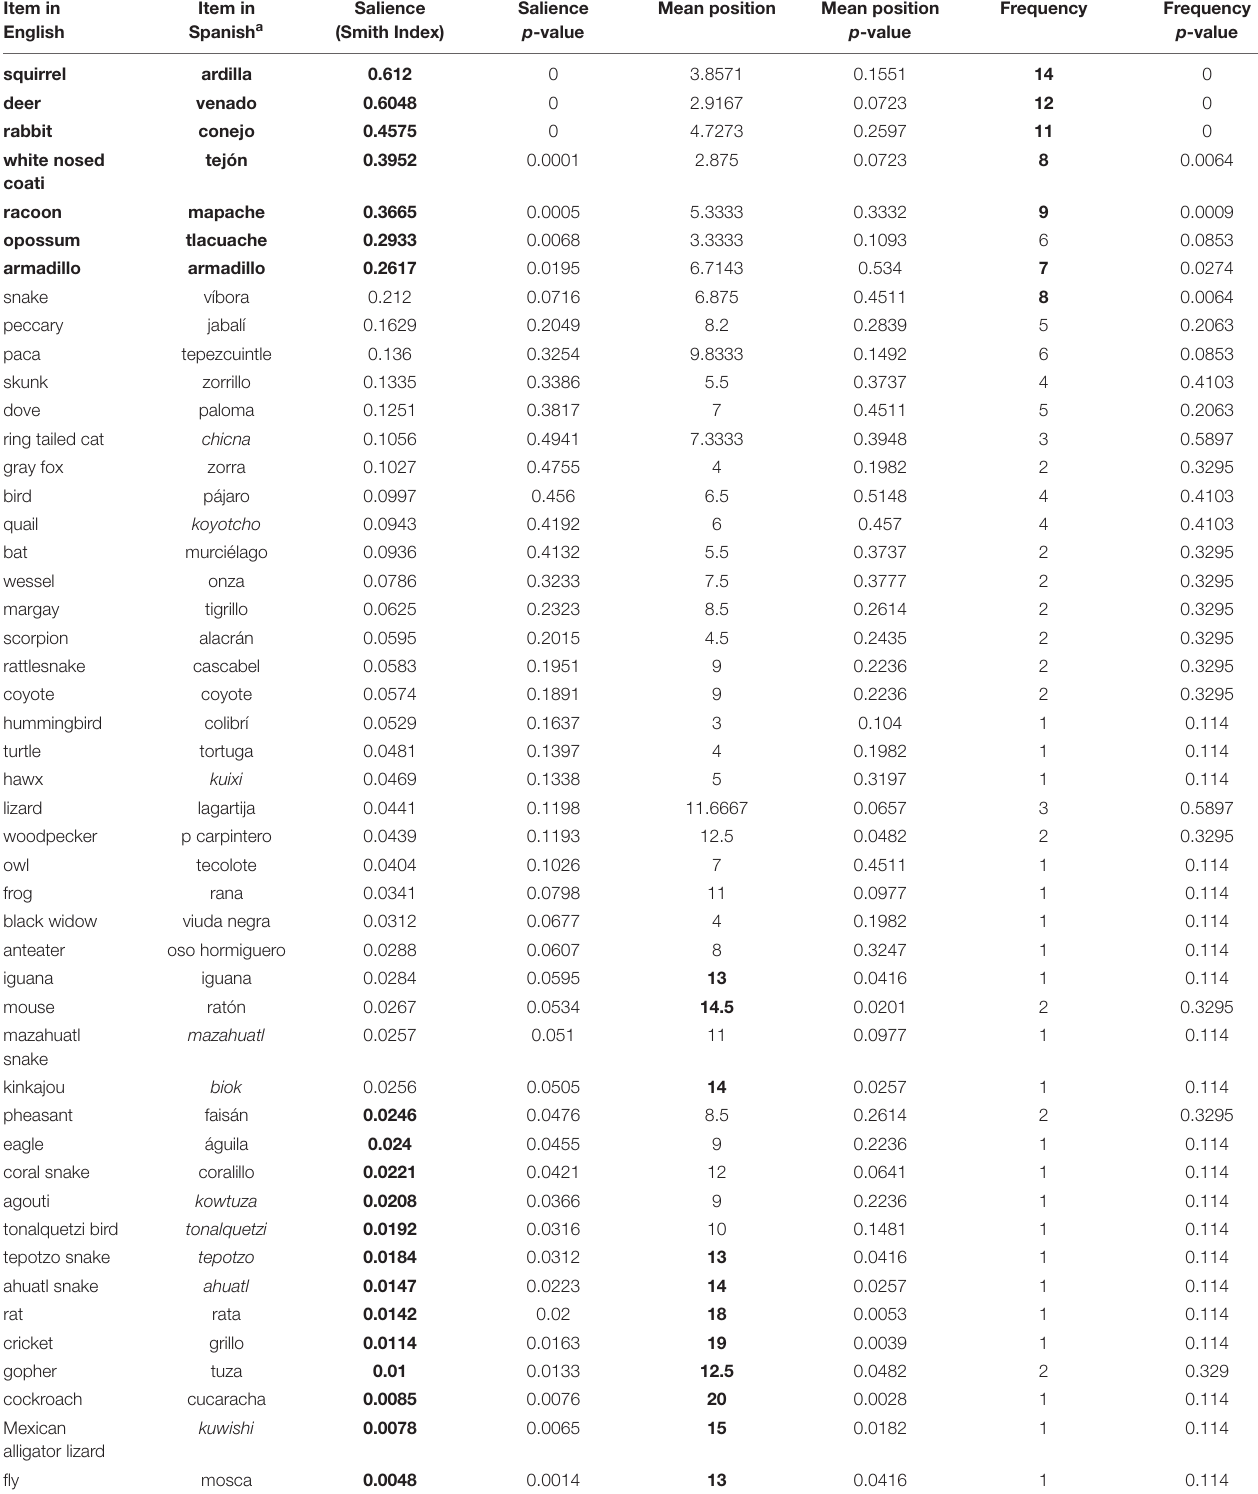
TABLE 4 | Smith salience index, mean position, and frequency of wild animal items in 16 adults’ free lists, with p